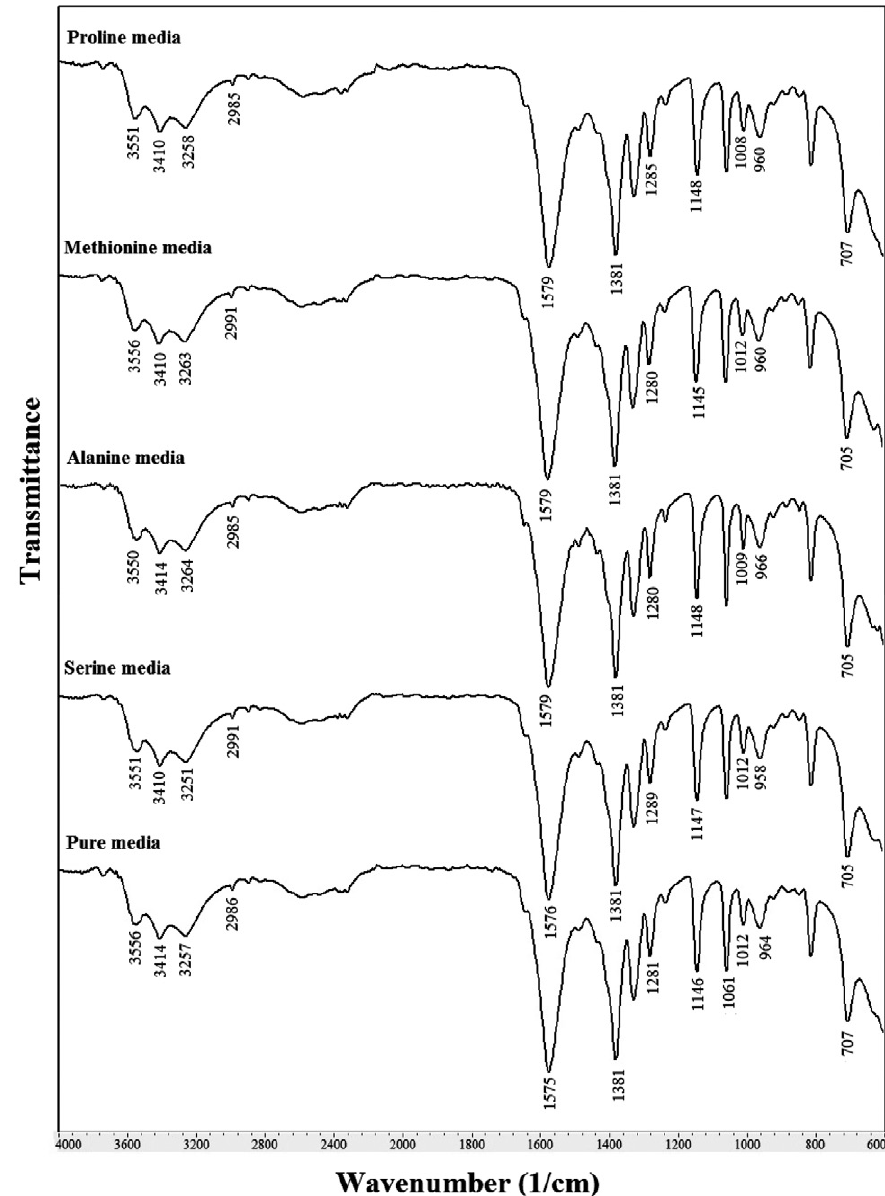
Figure 3. FTIR spectra of the CTT crystals obtained in pure media and media supplemented with various amino